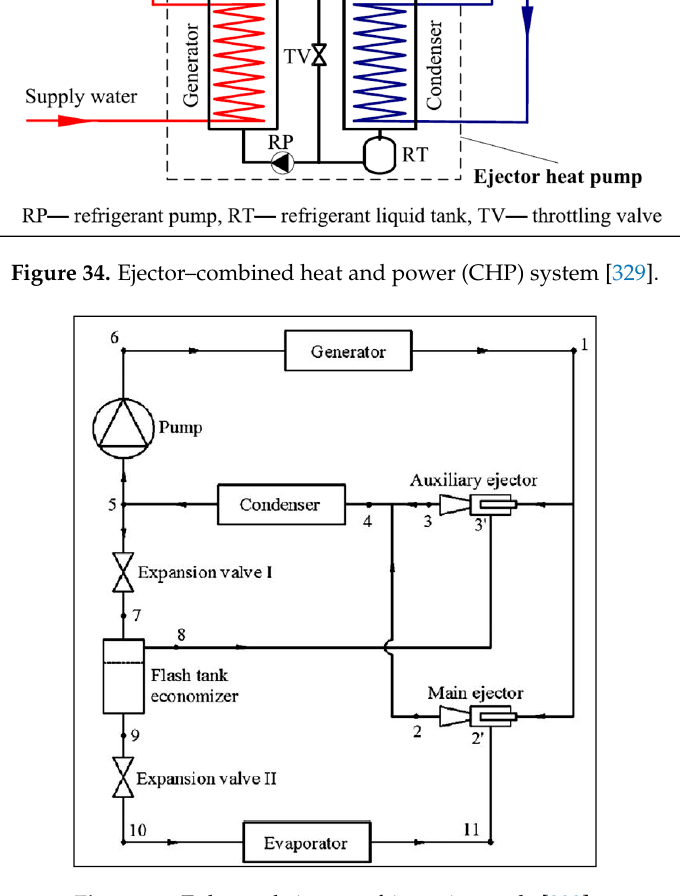
Figure 34. Ejector–combined heat and power (CHP) system [329].